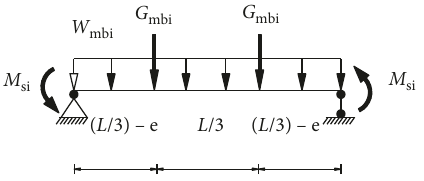
Figure 7: Free body diagram of middle span